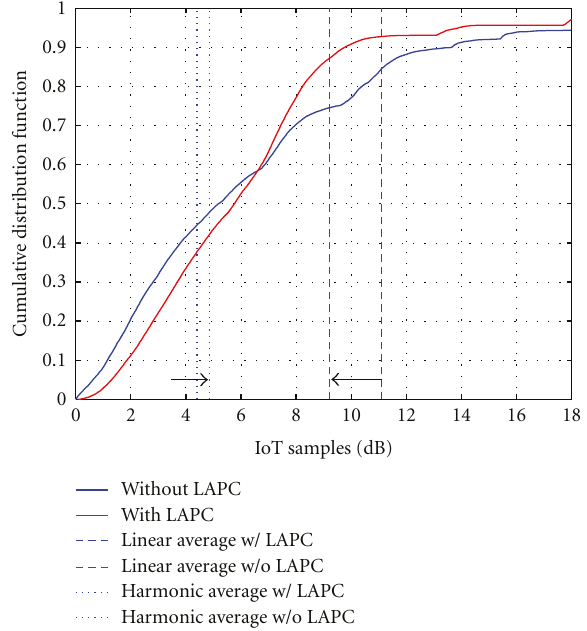
Figure 10: IoT distribution in overloaded cell no.11 with and without